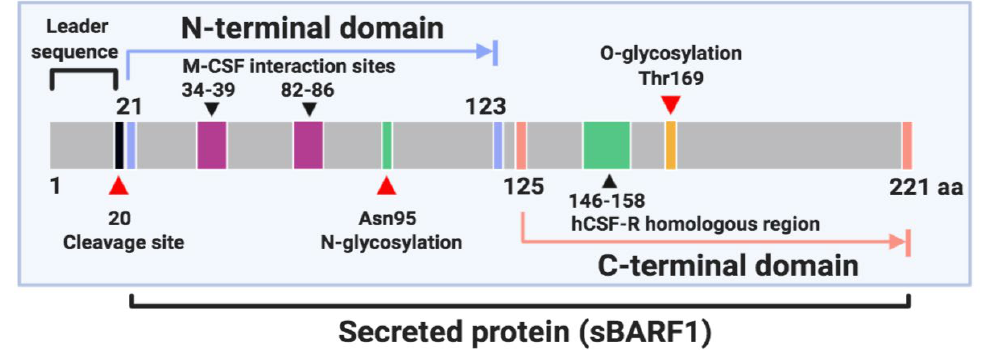
Figure 1. Schematic representation of BamHI-A rightward frame 1 (BARF1) protein.